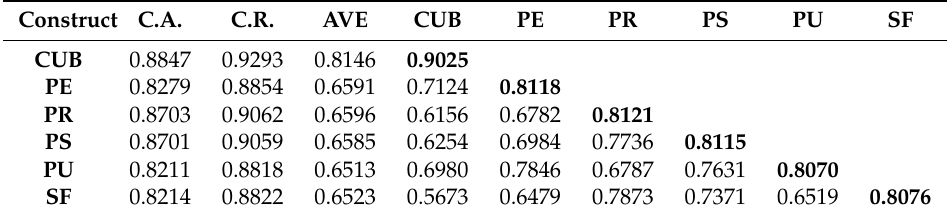
Table 3. Measurement Model Results.